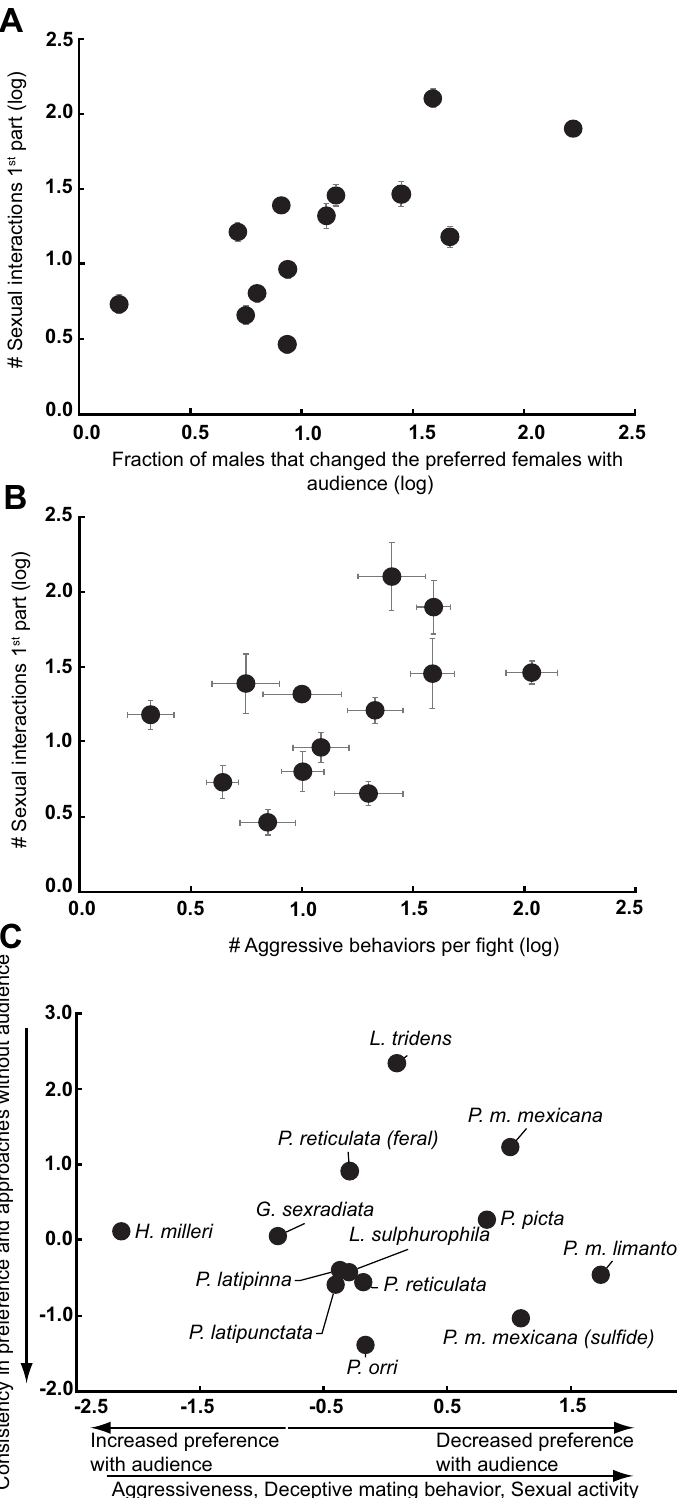
Figure 3. Correlations between species-level means (± SE) of male aggressiveness (log(number of aggressions per fight)) and ( a ) sexual activity (log(number of sexual interactions during the 1 st part)) and ( b ) deceptive mating behavior (fraction of males that changed the first approached female from 1 st part to 2 nd test part with an audience present). ( c ) First two principle components from PCA with species-level means of all seven behaviors determined in this study. Axis loadings >0.63 are given along the respective